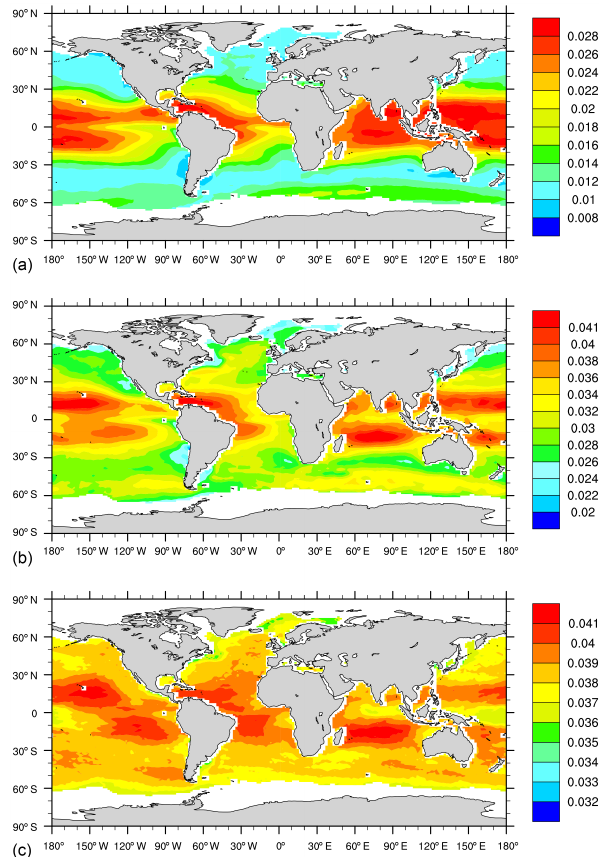
Figure 8. Modelled ozone dry deposition velocity ( v d , cms − 1 ) av- eraged over the year 2006 obtained using the two-layer reactivity scheme (a) , the one-layer reactivity scheme (b) , and the default scheme with surface resistance r c = 2200sm − 1 (c) . Note differ- ences in scale.